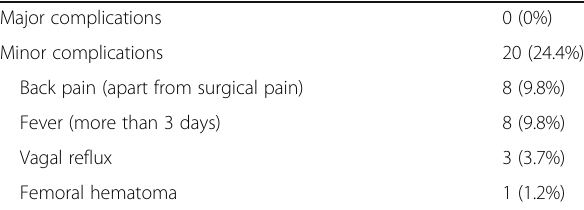
Table 3 Complications after